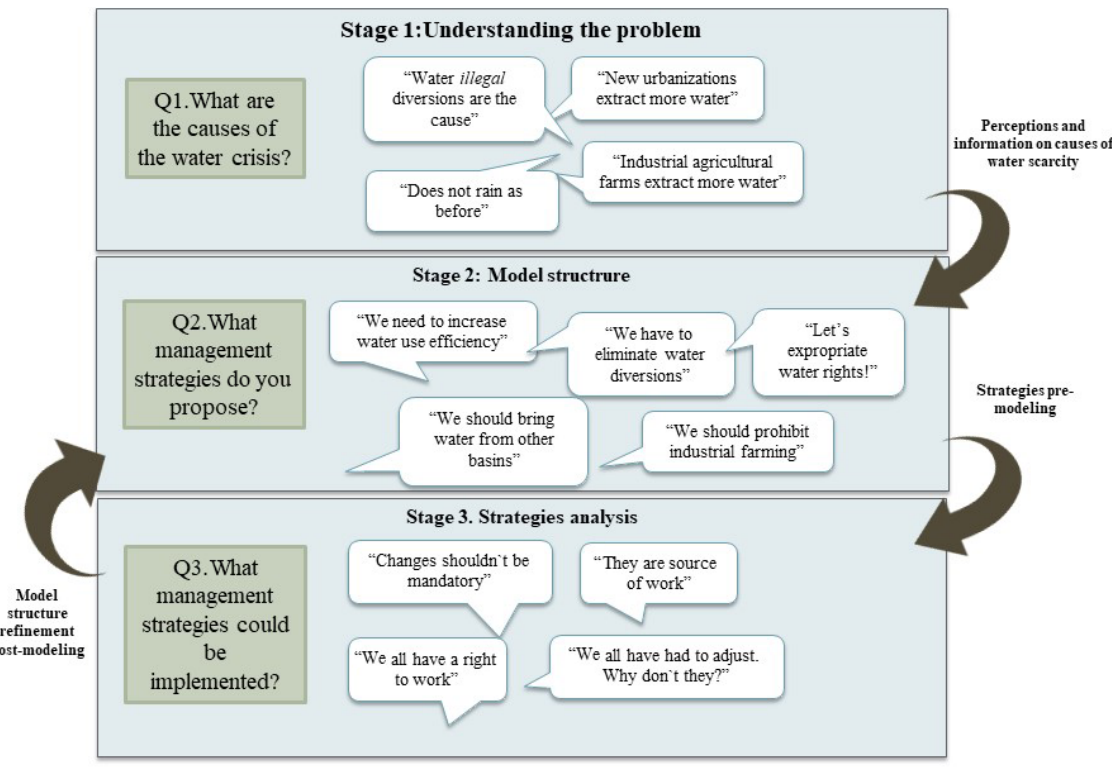
Figure 3. Main questions that emanated from the voluntary agreement conversations that fed the modeling process in terms of framing the problem, designing the base structure, and identifying potential